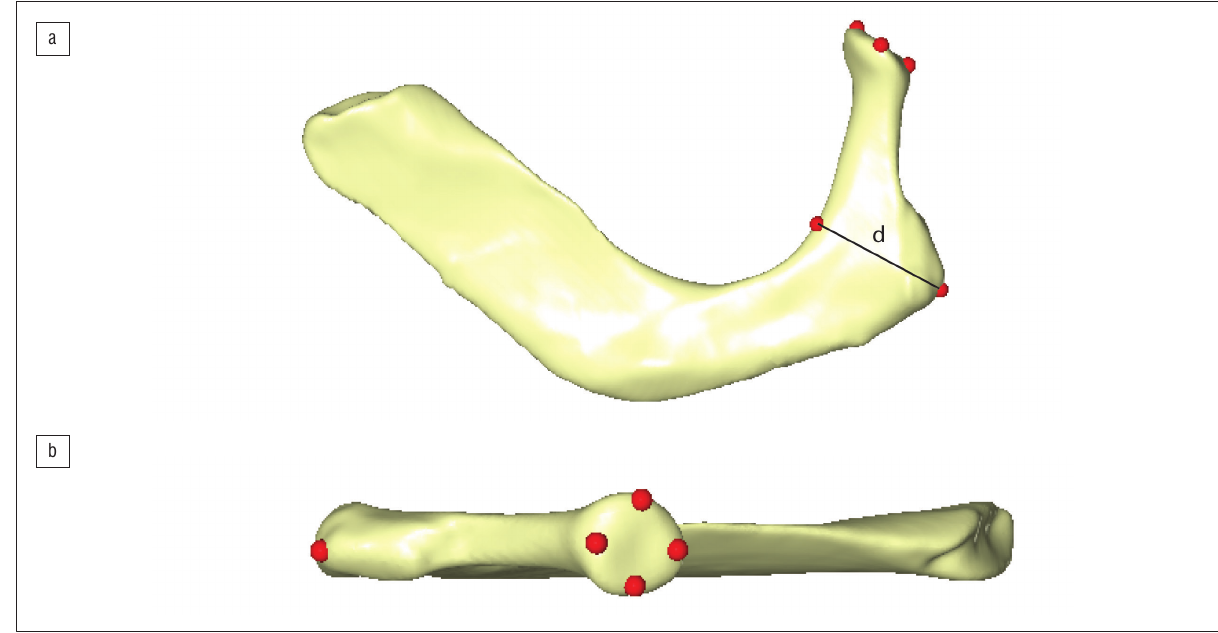
Figure 3: Anatomical location of the six landmarks type 1 taken on the sample. In (a), landmarks at the rib head on the most lateral, most medial and most cranial points of the articular facet/s of the rib head as well as at the most lateral point of the articular tubercle and the landmark defined by the distance ‘d’ are observed. In (b), the four landmarks at the rib head as well as the one at the tubercle are observed. Measurement ‘d’ is defined by the shortest distance from the most lateral point of the articular tubercle to the internal margin, which is important to calculate the landmark defined by this